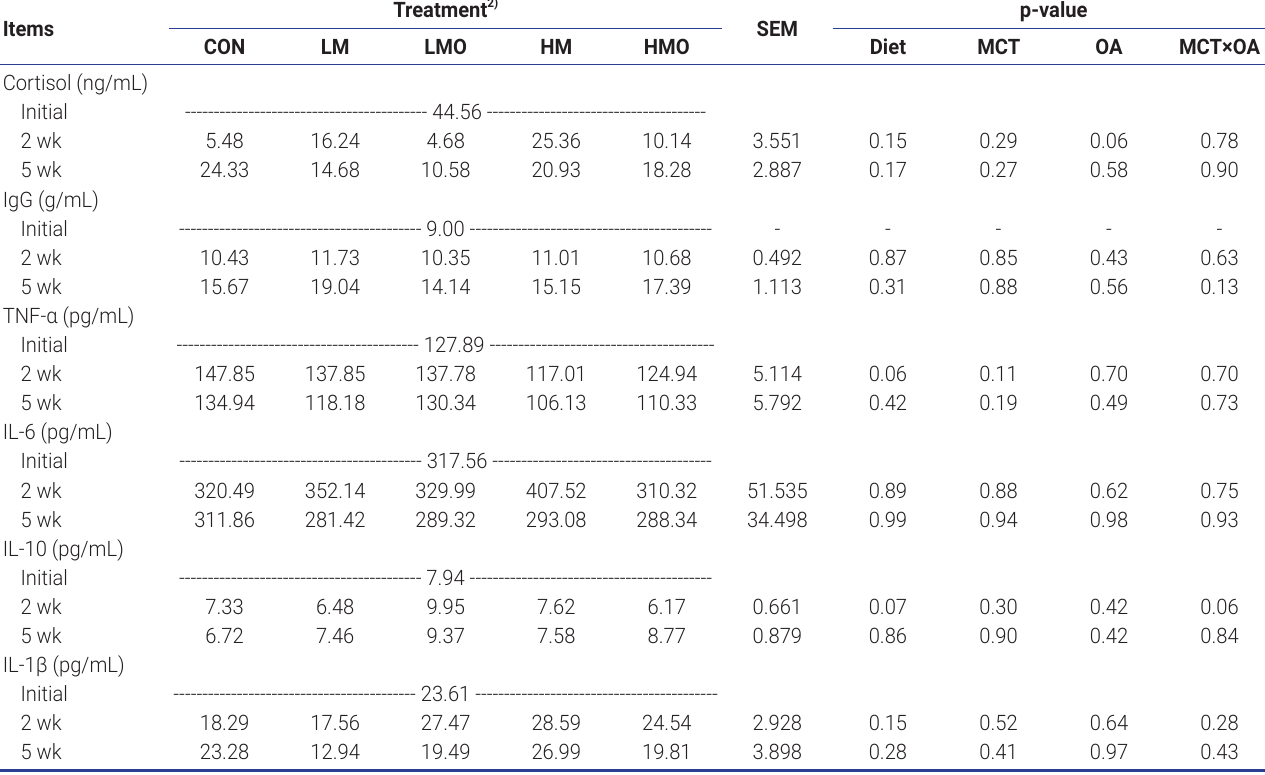
Table 5. Effects of medium chain triglycerides and organic acids on blood profiles in weaning pigs 1)